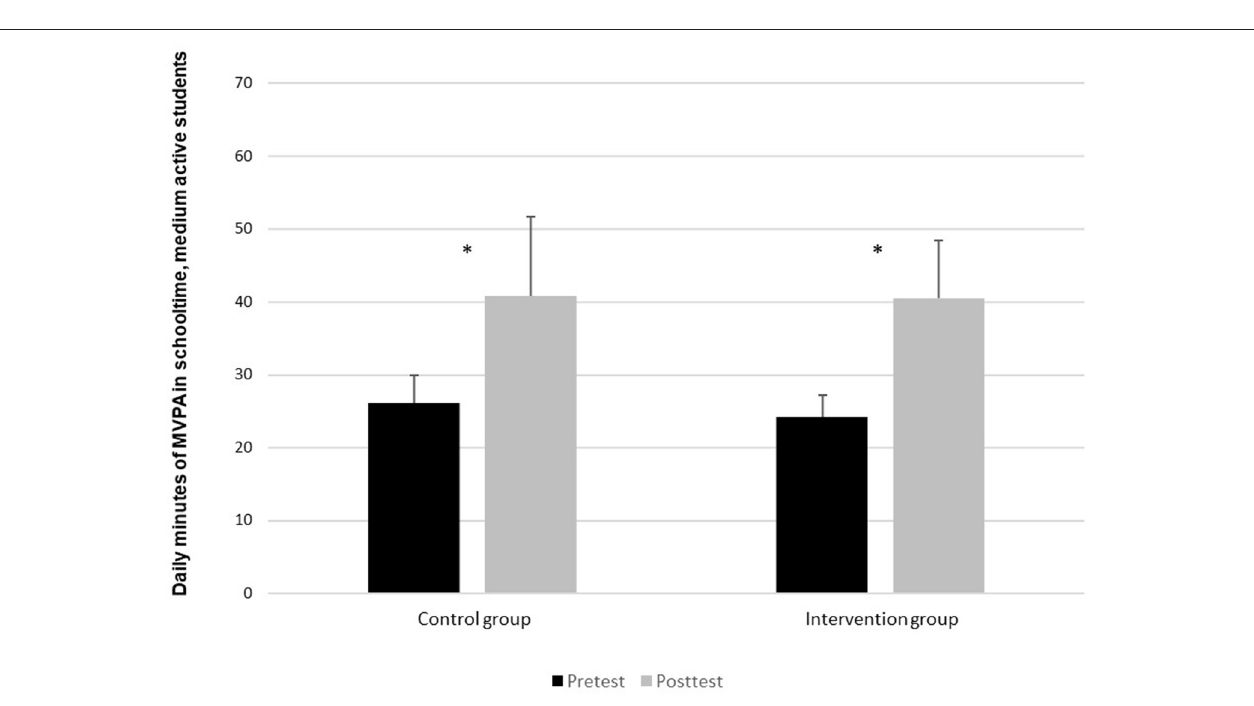
FIGURE 3 | Daily contribution of MVPA in schooltime for pupils in the medium-active group, divided between pre-test and post-test. *Indicates a significant difference ( p < 0.05) between pre-test and post-test in daily MVPA in